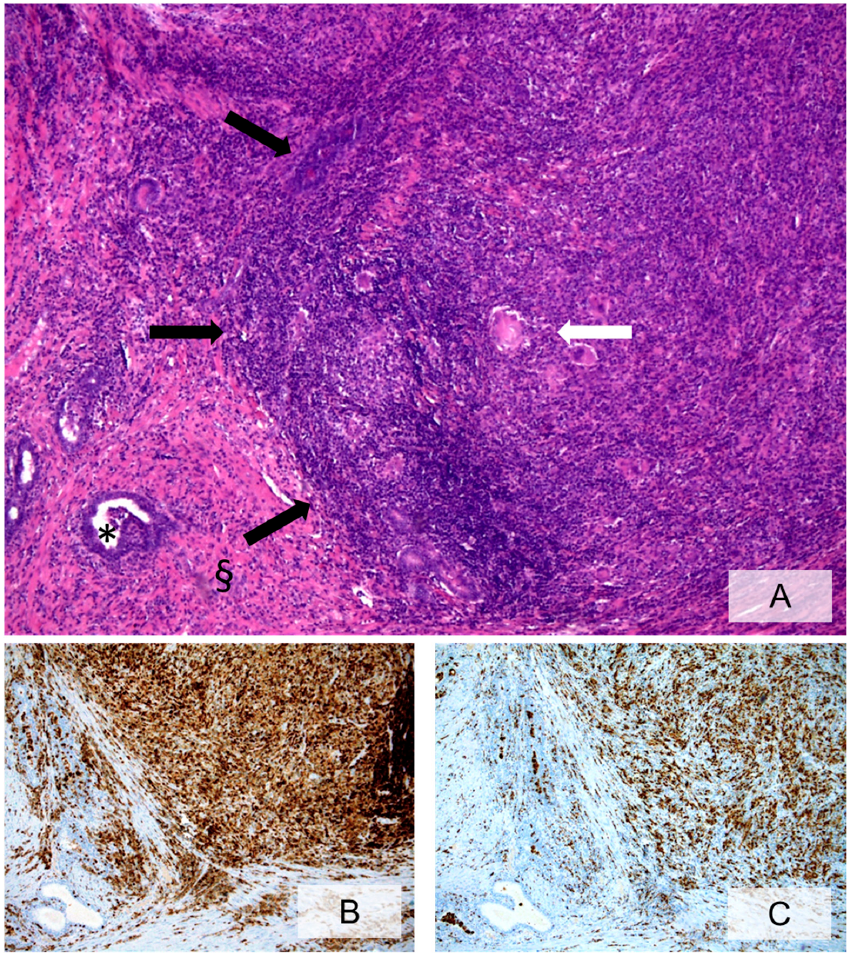
Figure 3. Granulomatous prostatic inflammation ( A , H&E, ×10, black arrows = circumscribed granulomatous inflammatory infiltrate; occasional foreign-body-like giant cells within the granuloma, * = prostatic glandular lumina, § = prostatic stroma). Immunohistochemical staining with anti-CD45 ( B , ×10) and anti-CD68-PGM1 ( C , ×10) labels the lymphocyte and the histiocyte components, respectively.